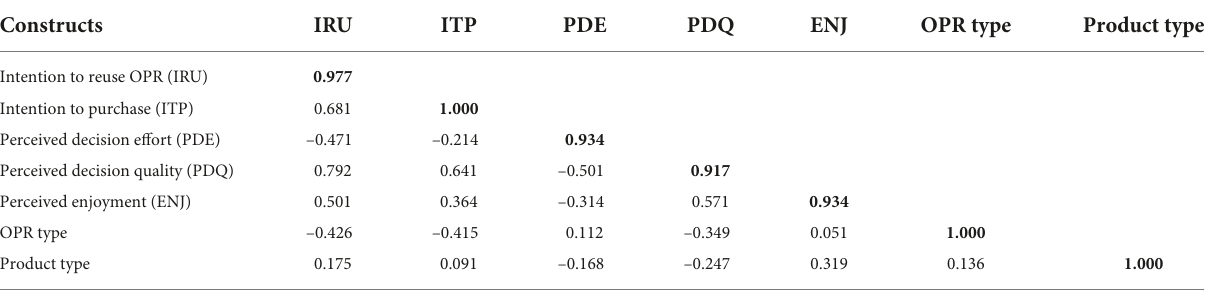
TABLE 7 Assessment of discriminant validity and correlation.